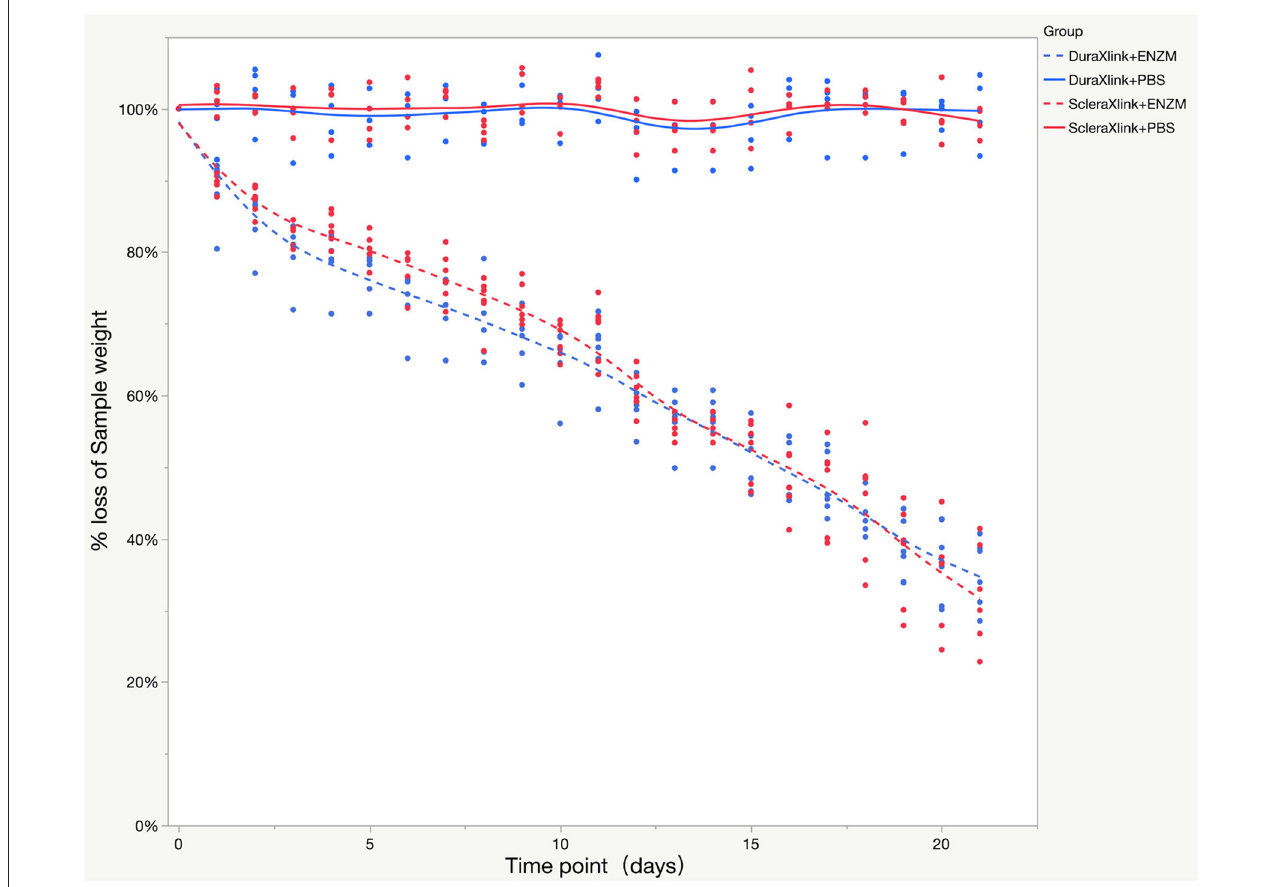
FIGURE 3 | Enzyme degradation test of both crosslinked sclera and crosslinked dura mater over time while PBS was used as control. The data were presented as a percentage weight loss from original sample during 3 weeks of study. Xlink, crosslink; PBS, phosphate buffered saline; ENZM, protease XIV, 1 U/ml with 1%